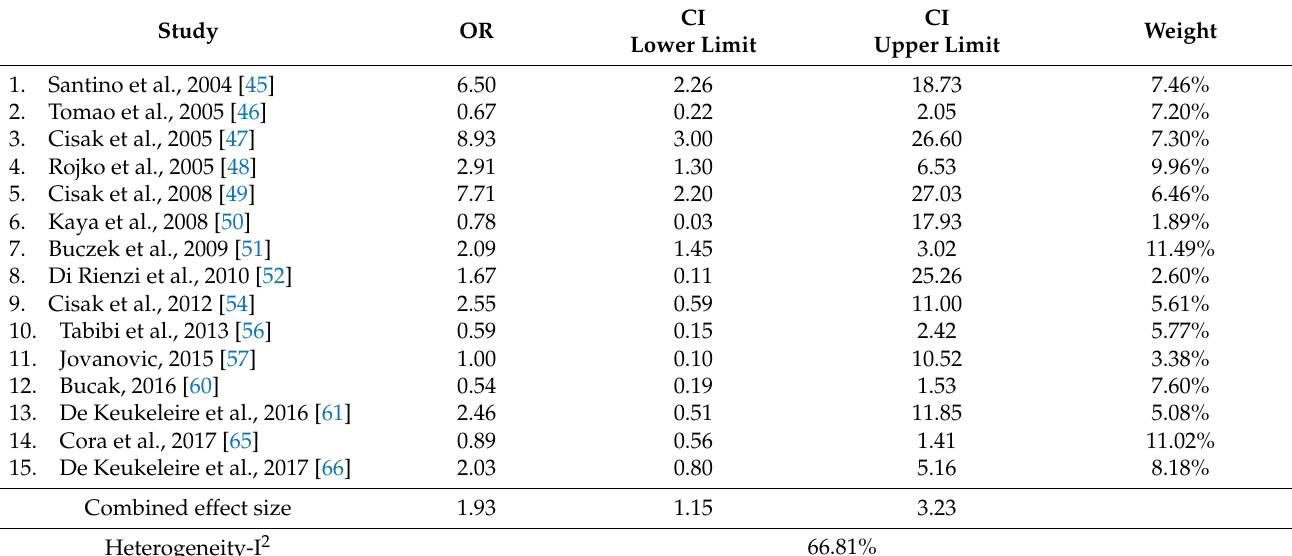
Table 2. Comparison of outdoor workers with controls. Meta-analysis of 15 studies.